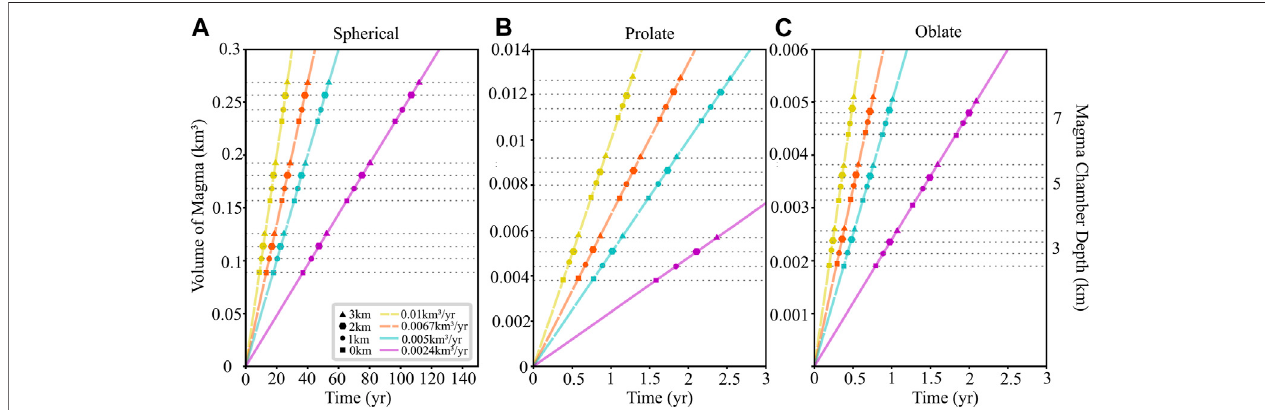
FIGURE 4 | Volume of magma added into the chamber versus time with steady fl ux rates of 0.0024, 0.005, 0.0067 and 0.01 km 3 /yr for (A) spherical, (B) prolate, and (C) oblate chambers. The spherical chamber has a radius of ~0.62 km. The prolate magma chamber has radii of ~0.49 and 0.98 km, and oblate chamber radii are ~0.39 and 0.78 km. Along each linear fl ux rate line, the times to failure of several different systems are indicated by points. Each magma chamber depth (3, 5 and 7 km) has four points representing the times to failure for each ice cap thickness (0, 1, 2 and 3 km). Tensile failure for systems with identical magma chamber depths and ice cap thicknesses occur at similar volumes, whose average approximations are represented by the horizontal dashed grey lines.